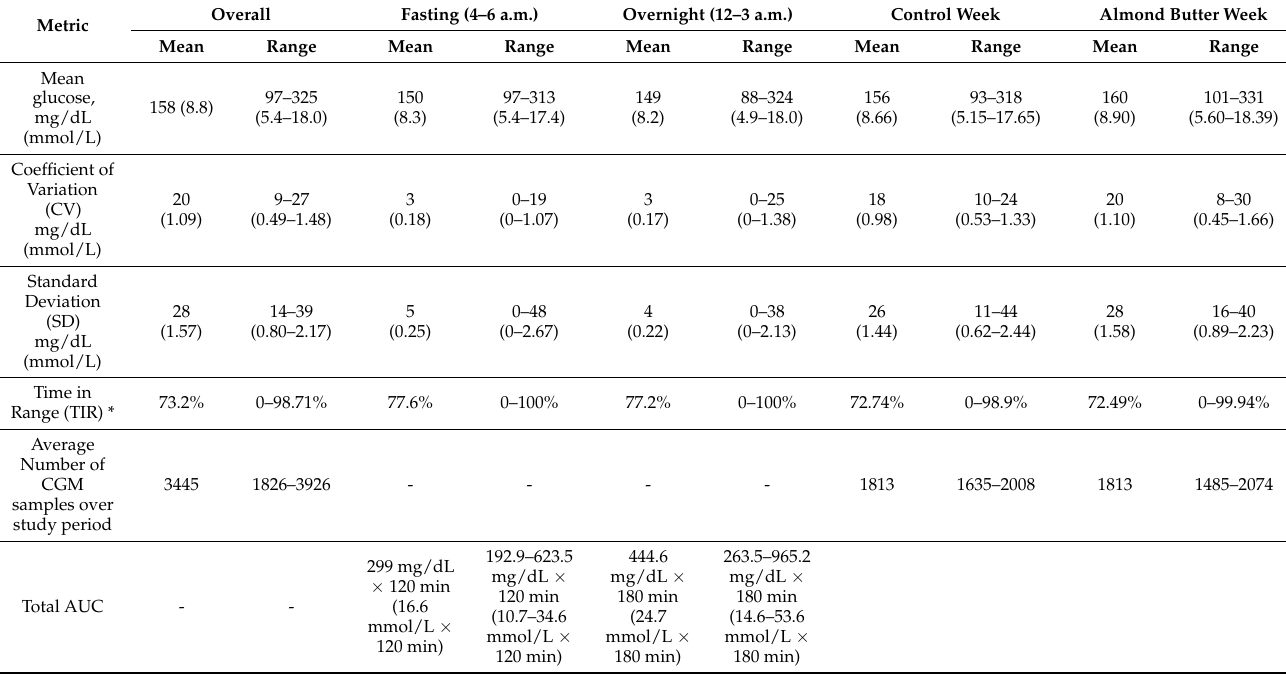
Table 3. Summary descriptive statistics of CGM